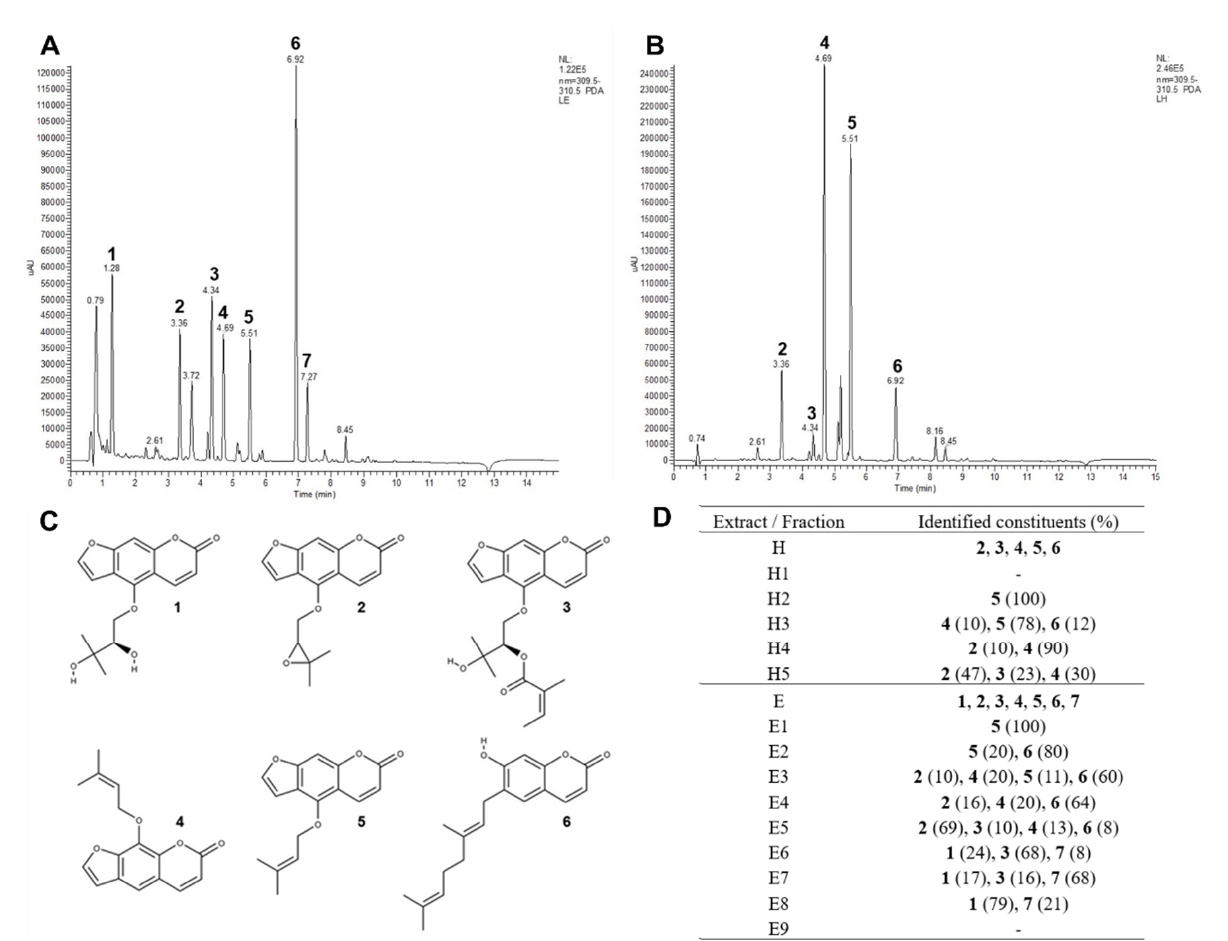
Figure 1. UV chromatogram of P. ostruthium ethanol (E) (A) and hexane (H) (B) extracts at 310 nm, molecular structures of main identified coumarins in Peucedanum ostruthium extracts oxypeucedanin hydrate ( 1 ), oxypeucedanin ( 2 ), ostruthol ( 3 ), imperatorin ( 4 ), isoimperatorin ( 5 ), ostruthin ( 6 ) (C) and constituents identified in extracts and subsequent fractions according to LC-PDA-ESI-MS n results with the relative composition of identified coumarins in subfractions (%) (D).